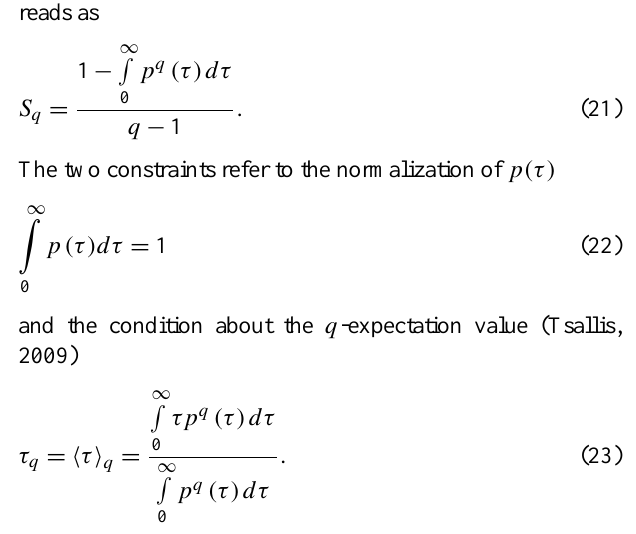
Fig. 5. (a) Normalized cumulative magnitude distribution for M ≥ M o = 1 (circles) and the model of Eq. (20) (solid line) for the values of q E = 1 . 37 ± 0 . 01 and α E = 19 . 05 ± 6 . 86. The dashed line repre- sents the G–R relation for b = 1 . 51 ± 0 . 03. (b) The corresponding energy distribution function (circles). The fitted curve (solid line) is according to Eq. (16) for the same values of q E and α E as previ- ously and the G–R relation (Eq. 7) for γ = 1 . 98 ± 0 . 03.